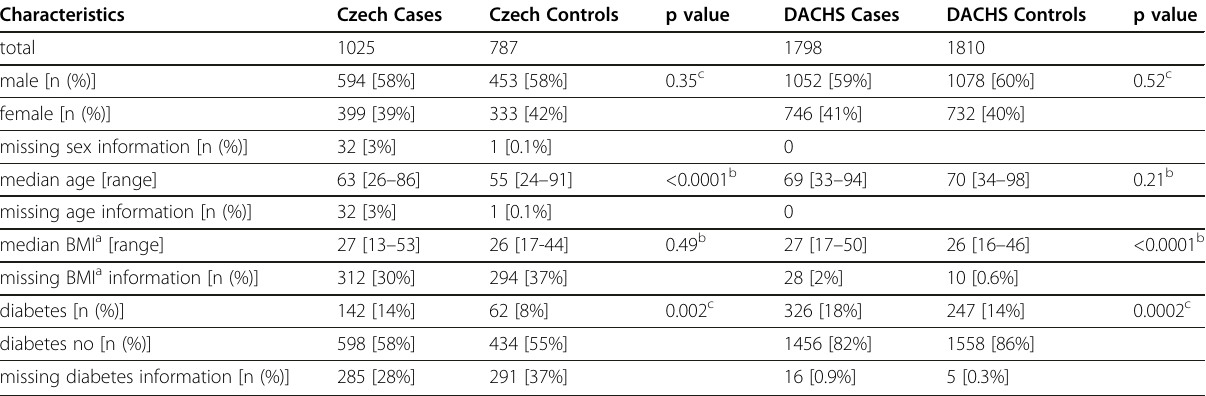
Table 2 Characteristics of the Czech and the DACHS study population, at the time of diagnosis for cases and at the time of sampling for